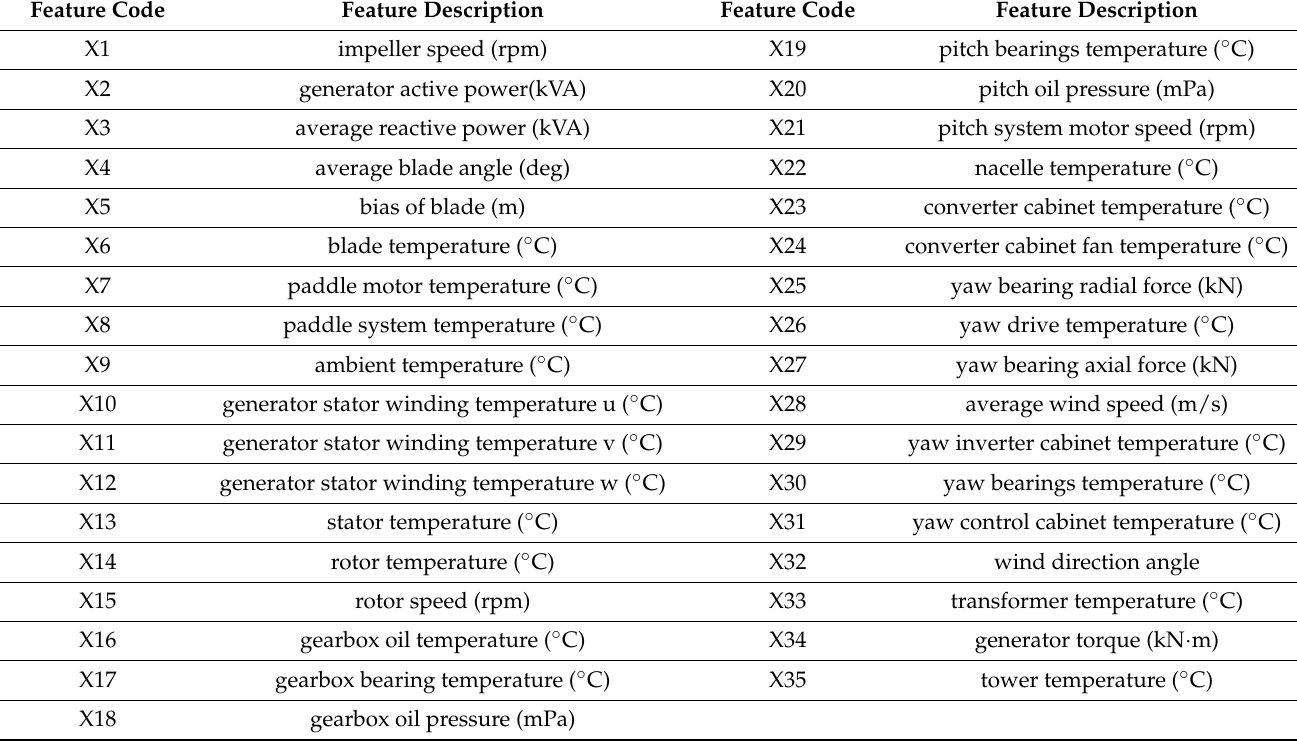
Table 6. Feature code and its description.